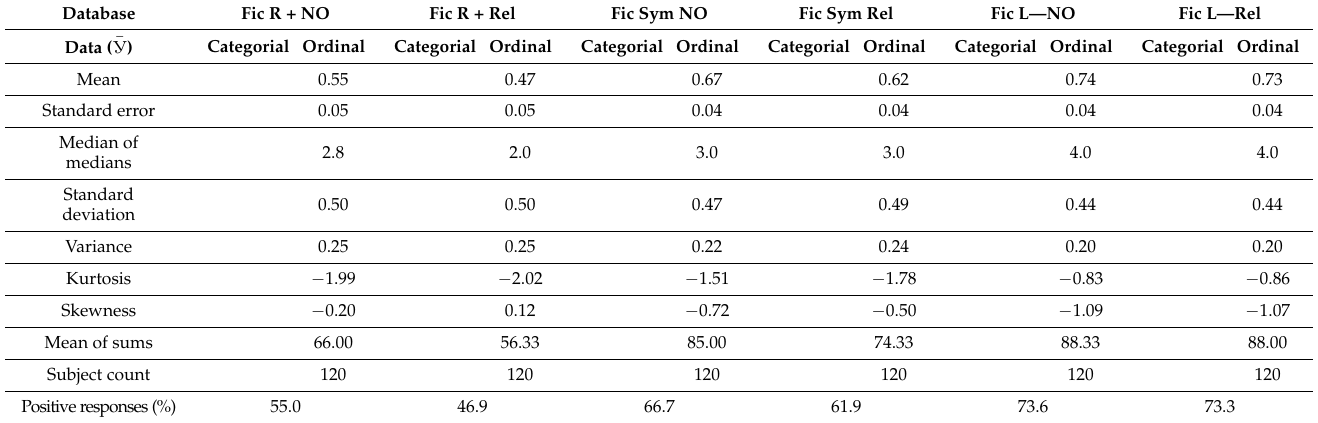
Table 3. Descriptive statistics of the databases.